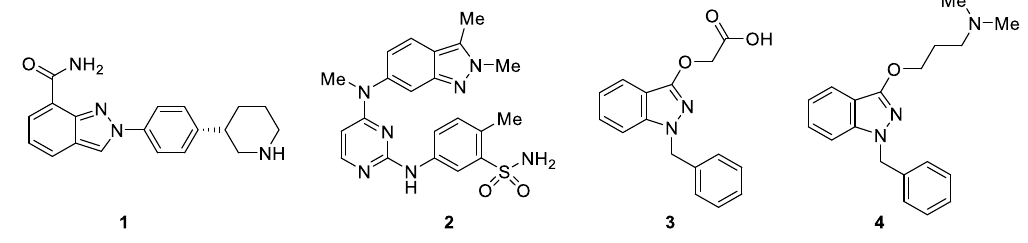
Figure 2. Chemical structure of indazole-containing drugs 1 – 4.